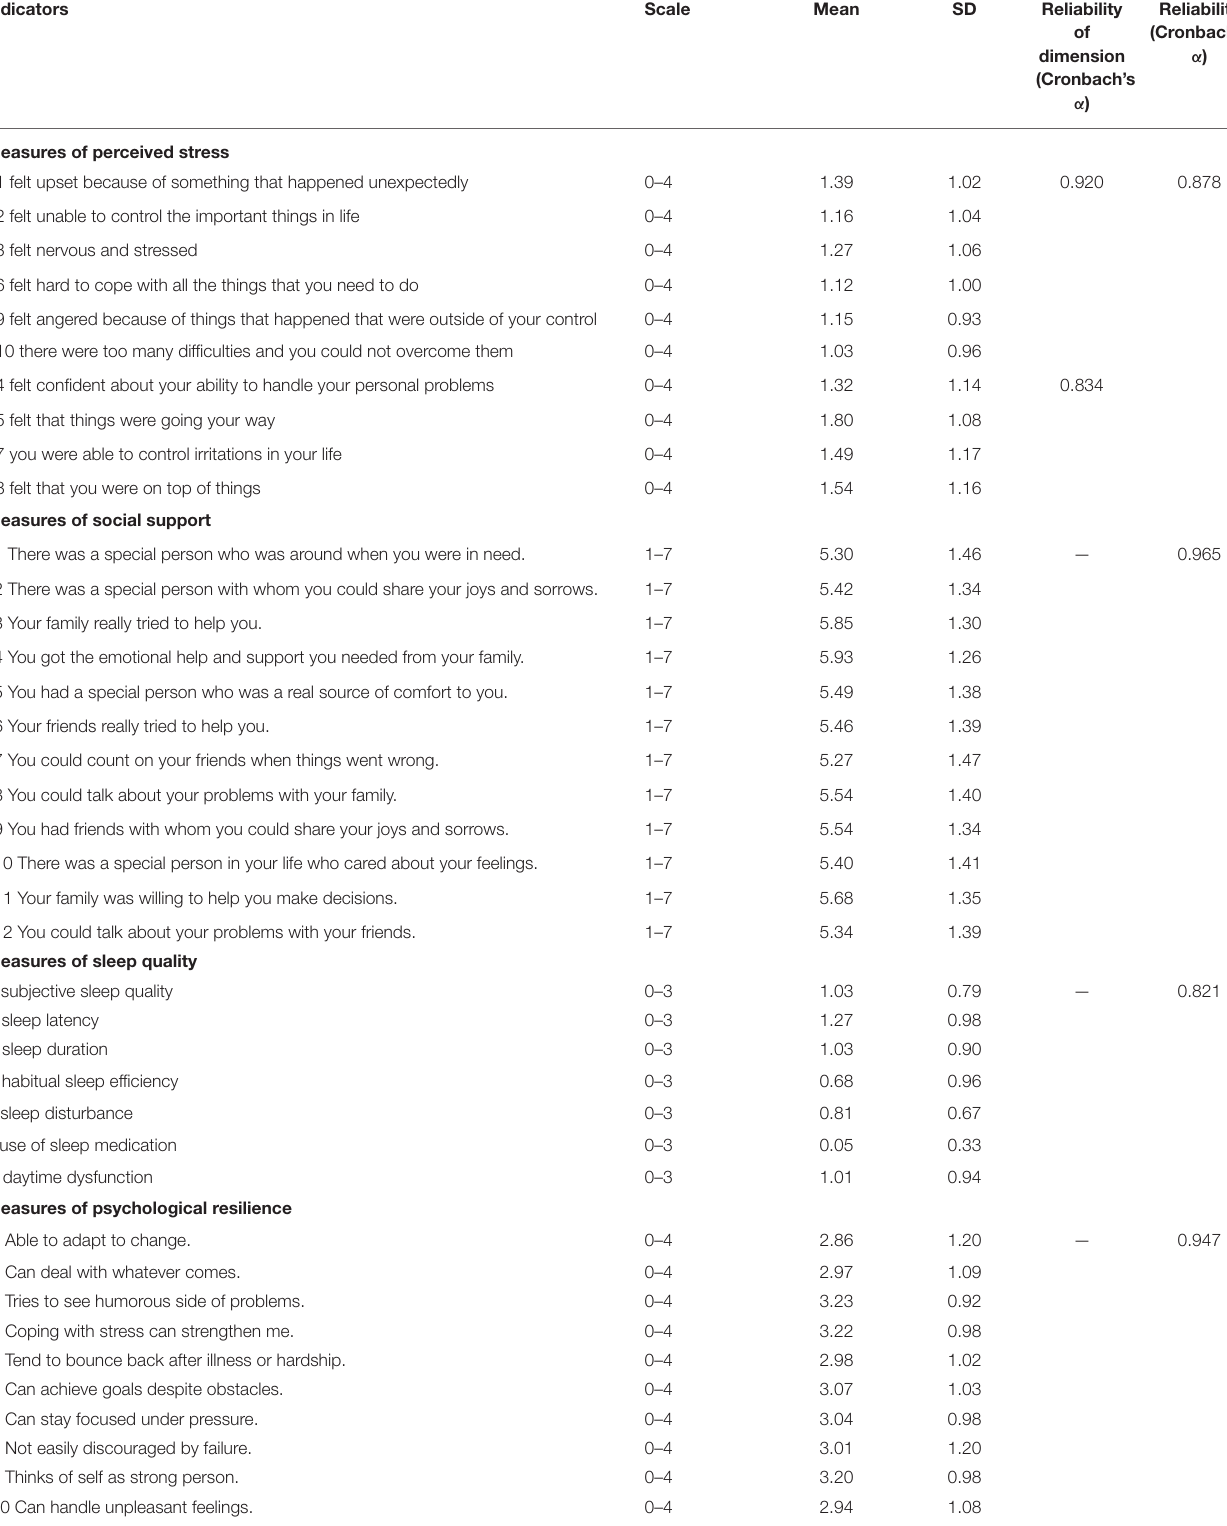
TABLE 1 | Measures of PSS, MSPSS, PSQI, and CD-RISC-10. Indicators Scale Mean SD Reliability